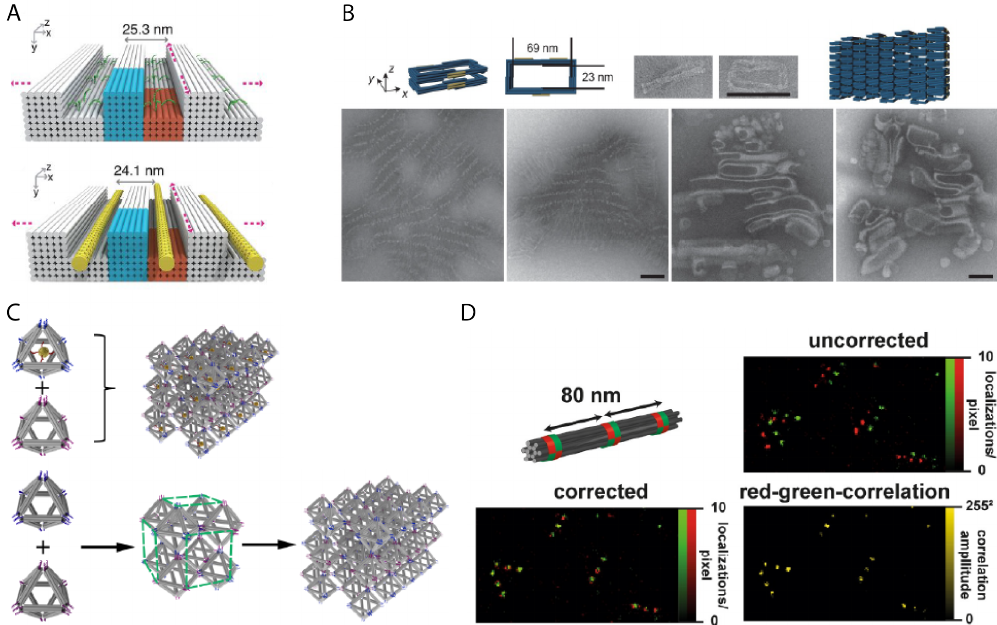
Figure 7. Applications of utilizing DNA nanostructures as a geometric template. ( A ) Pitch-scaling of carbon nanotubes by trenches constructed from DNA bricks (reprinted with permission from AAAS [126]); ( B ) Liposomes scaffolded by a DNA origami cage can replicate the appearance of the golgi apparatus (reprinted with permission from Springer Nature [120]); ( C ) Gold nanoparticles placed within polyhedral DNA nanostructures that assist in placing the gold nanoparticles in crystalline lattice positions (reprinted with permission from Springer Nature [44]); ( D ) A DNA origami bundle with tailored spacing of fluorophore markers that assist in the calibration of images against drift (reprinted with permission from Springer Nature